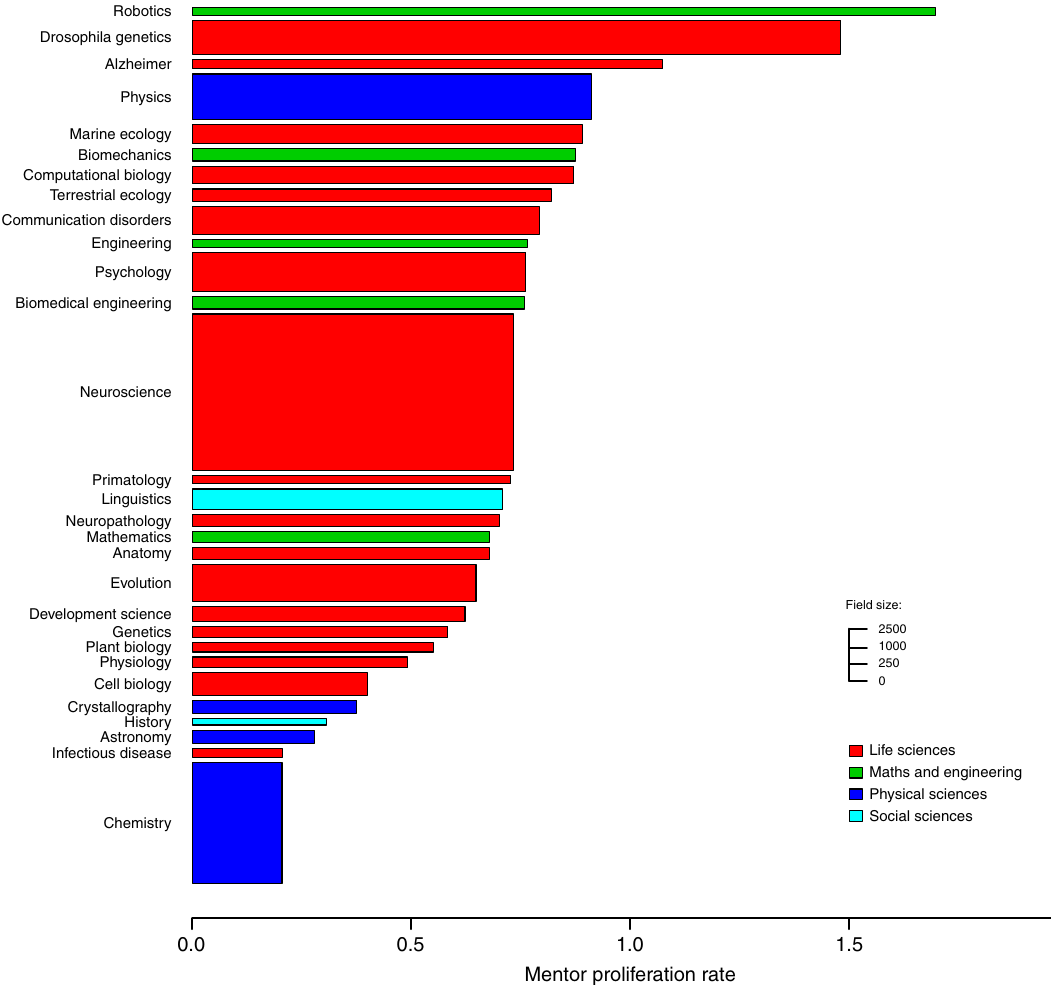
Fig. 7 Statistical mode of the mentor proliferation rates (horizontal axis) and sample size (number of triplets along the vertical axis). Life Sciences (red) are well-represented in the Academic Family Tree dataset, and thus were the focus of the current study. In most sub- fi elds, the annual proliferation rate is between 0.5 and 1 (one new trainee every year or every other year). Maths and Engineering fi elds (green) show generally higher proliferation rates,